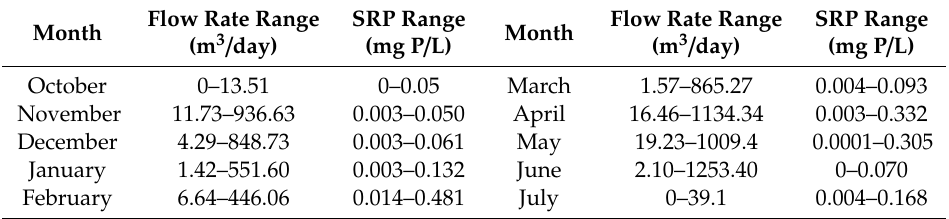
Table 4. Summary of the flow rate and soluble reactive phosphorous (SRP) concentration range